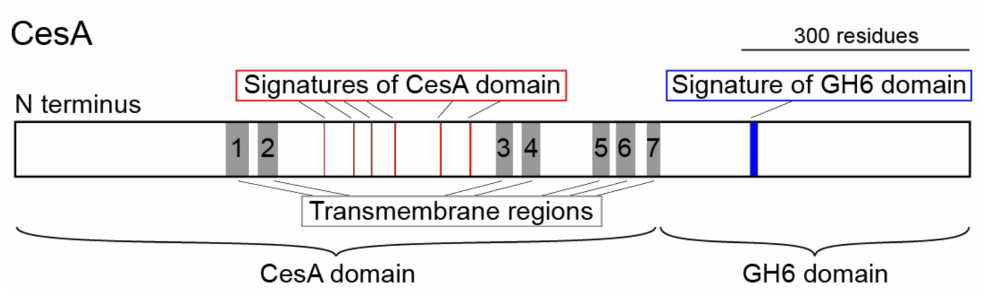
Figure 1. The composition of tunicate CesA, shown by a schematic of the domains. Tunicate CesA is a seven transmembrane (TM) domain protein, and a fusion protein of CesA and GH6 domains that are separated at the end of TM7. Red indicates sequences used for CesA domain identification and blue indicates sequences used for GH6 domain identification. Molecular signatures of CesA and GH6 domains follow Nakashima et al.